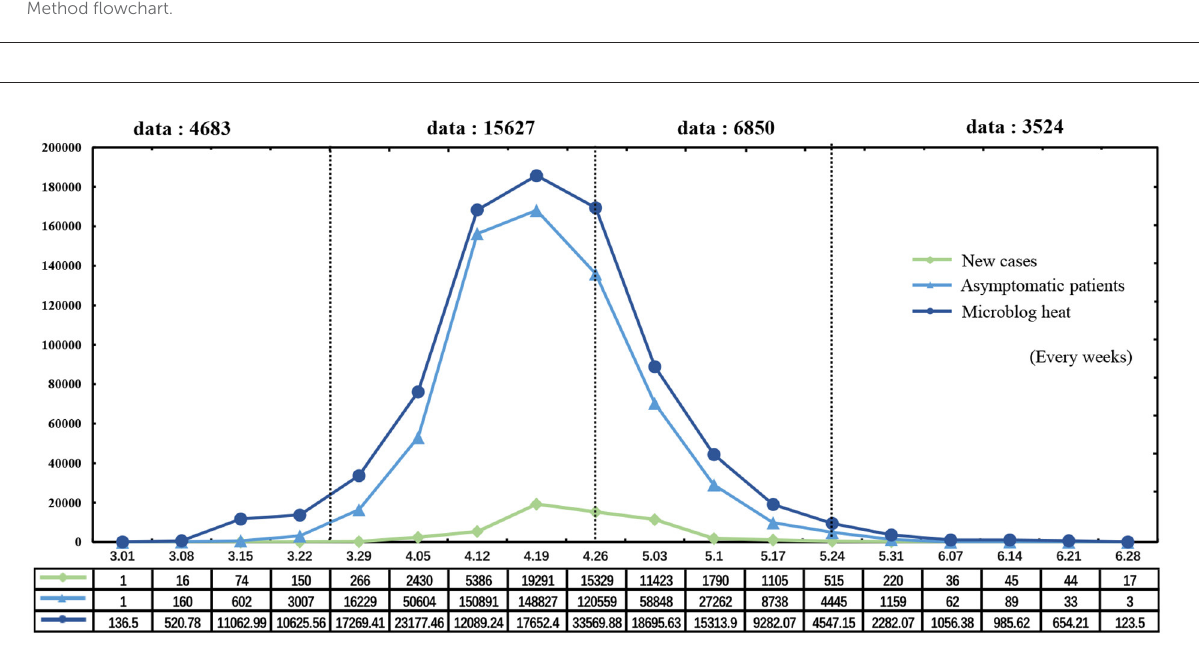
FIGURE2 Data collection